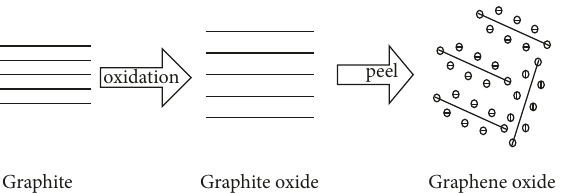
Figure 3: Legend of stripping operation.